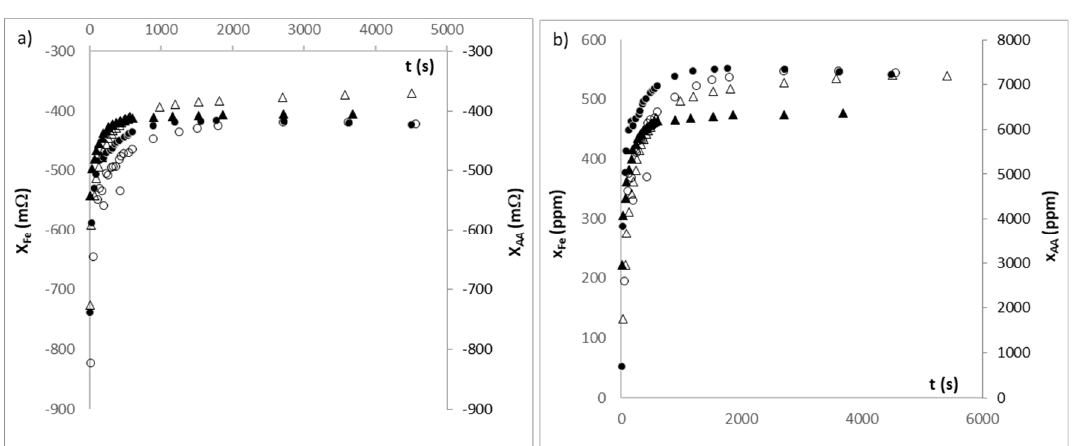
) is iron ion released at (cid:35)